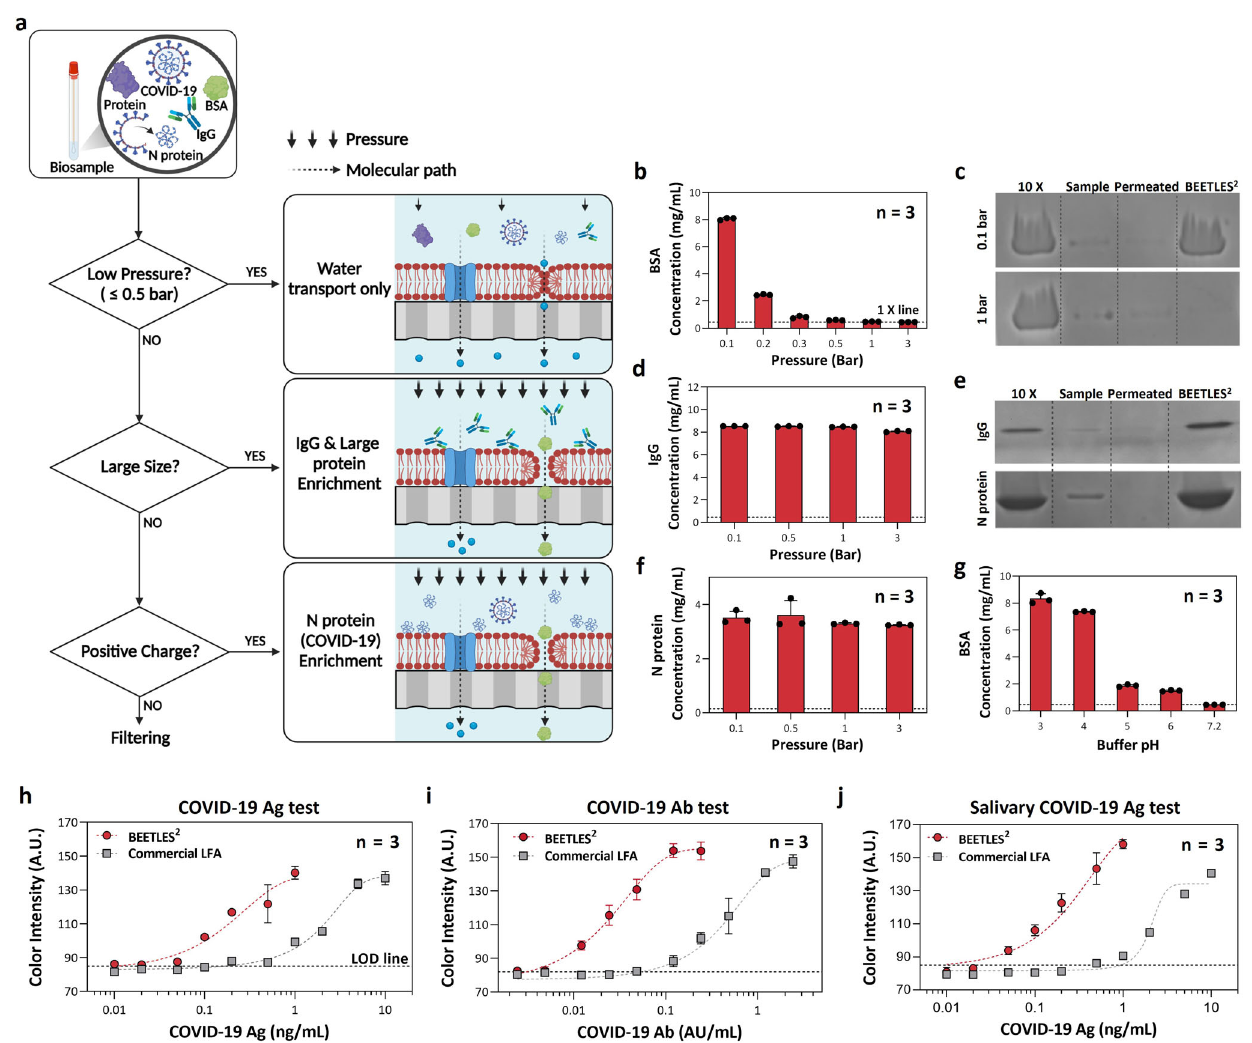
Fig. 3 | Assay performance validation. a Flowchart showing the permselectivity and tunability of BEETLES 2 membrane by pressure, molecular size, charge, and buffer conditions. b Pressure effect on the enrichment: negatively charged BSA withastrongdependencyonpressure,showingtunablepropertiesunderpressure. c SDS-PAGE of BSA (MW: 66.5kDa) d Size-based enrichment: Immunoglobulin G (IgG). e SDS-PAGE of IgG (MW: 150kDa) and N Protein (MW: 46kDa). f Surface charge-based enrichment (permselectivity): The enrichment with positively chargedNproteins. g Surfacechargeeffect(permselectivity):Theenrichmentwith